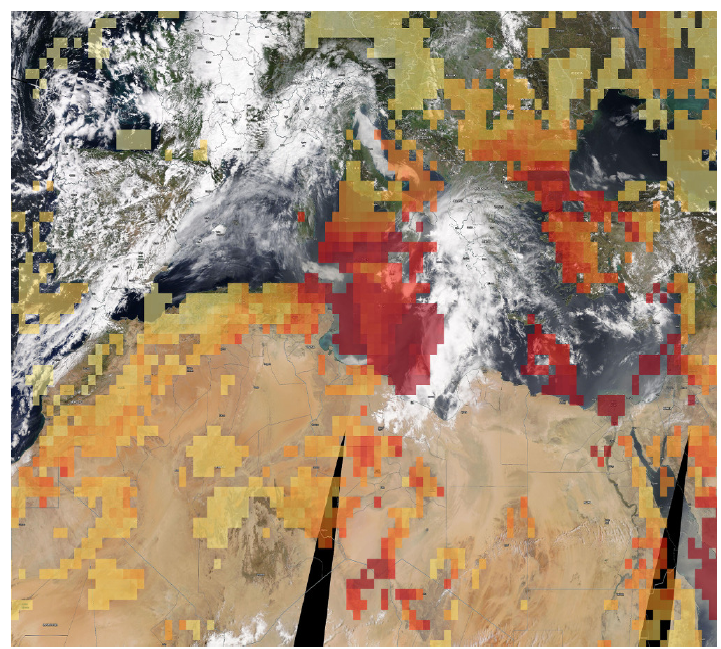
Figure 12. MODIS Combined Value-Added AOD for the 25 April 2019. The image is directly derived by the NASA’s platform